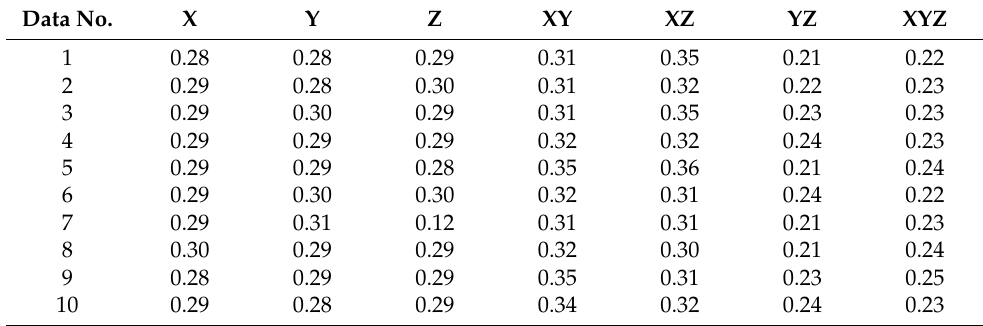
Table 8. CNN summary of ‘testing time’